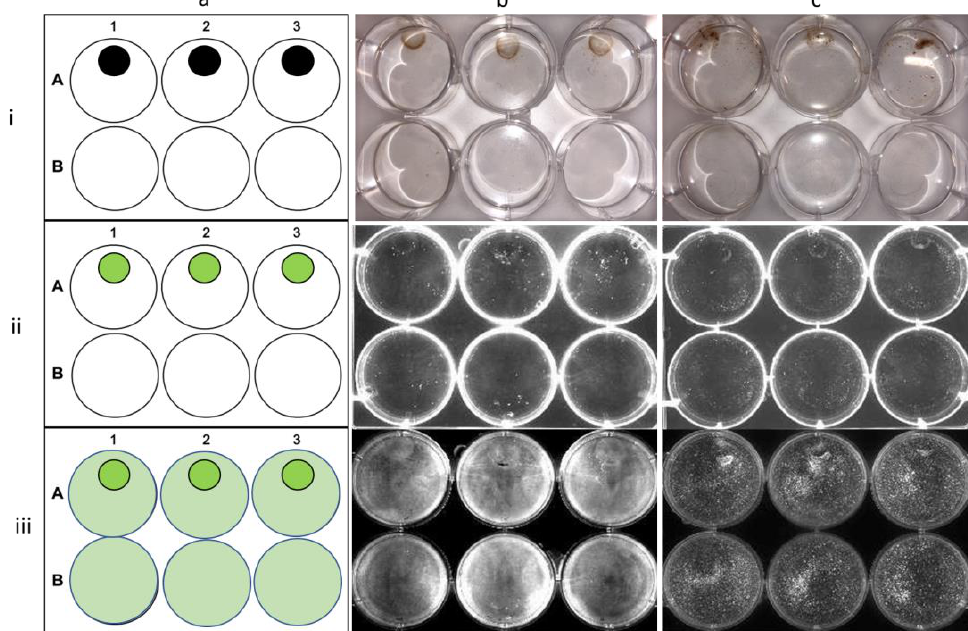
Figure 10. Magnetic localization of the NCC within cells. Demonstration of the magnetic direction ability of NCC in localizing RD cells (column b) and U-87 MG cells (column c) around a permanent magnetic field. Column a shows the position of permanent magnets in the plate and the regions of fluorescence. Permanent magnets were placed in wells A1, A2, A3, and B2. NCC-FITC-bearing cells were mixed with control cells in wells A1, A2, A3, and B1. Well B3 contained no NCC-bearing cells and no magnetic field as a control. Row (i) depicts the visible light image of the plate. Row (ii) displays the same plate fluorescently imaged at an excitation wavelength of 495 nm. Row (iii) shows the plate imaged fluorescently as in (ii) but with cell membrane dye present.